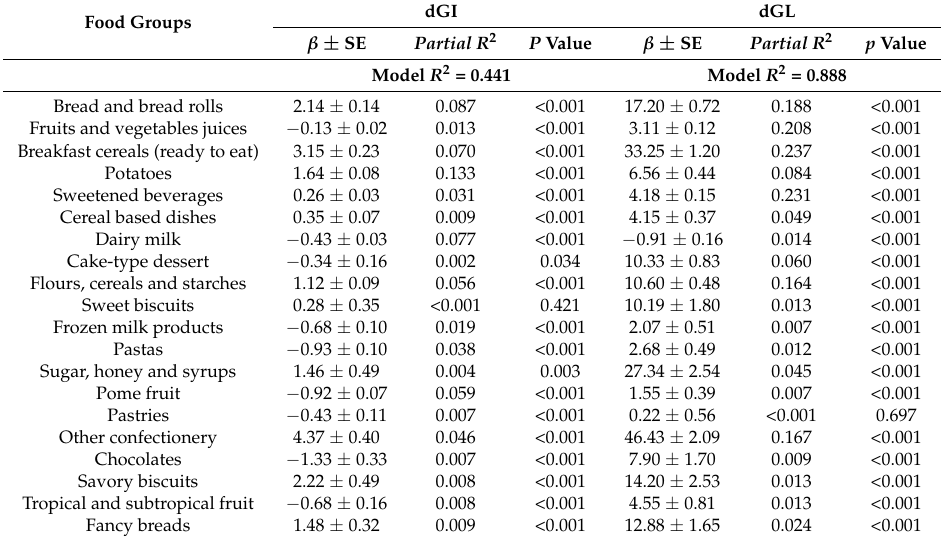
Table 5. The contribution of the top 20 GL food groups to inter-individual variations in dietary glycaemic index (dGI) and glycaemic load (dGL) in 1995NS ( n = 2475). Food Groups